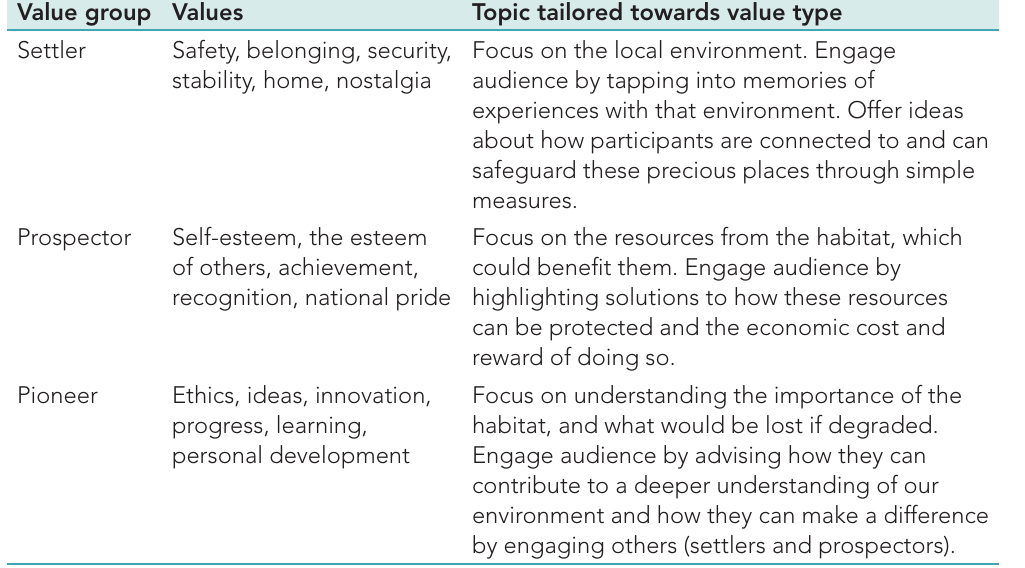
Table 2: examples of how a scientific message can be tailored according to the different value modes Value group